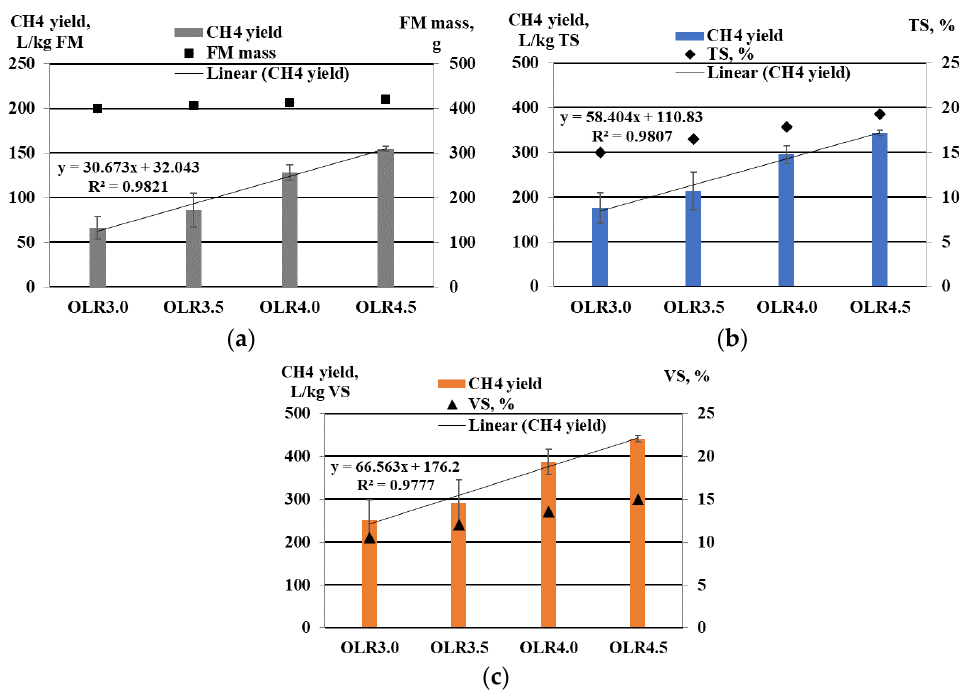
Figure 4. Methane yield: ( a ) CH 4 yield from FM; ( b ) specific CH 4 yield from TS; ( c ) specific CH 4 yield from VS.